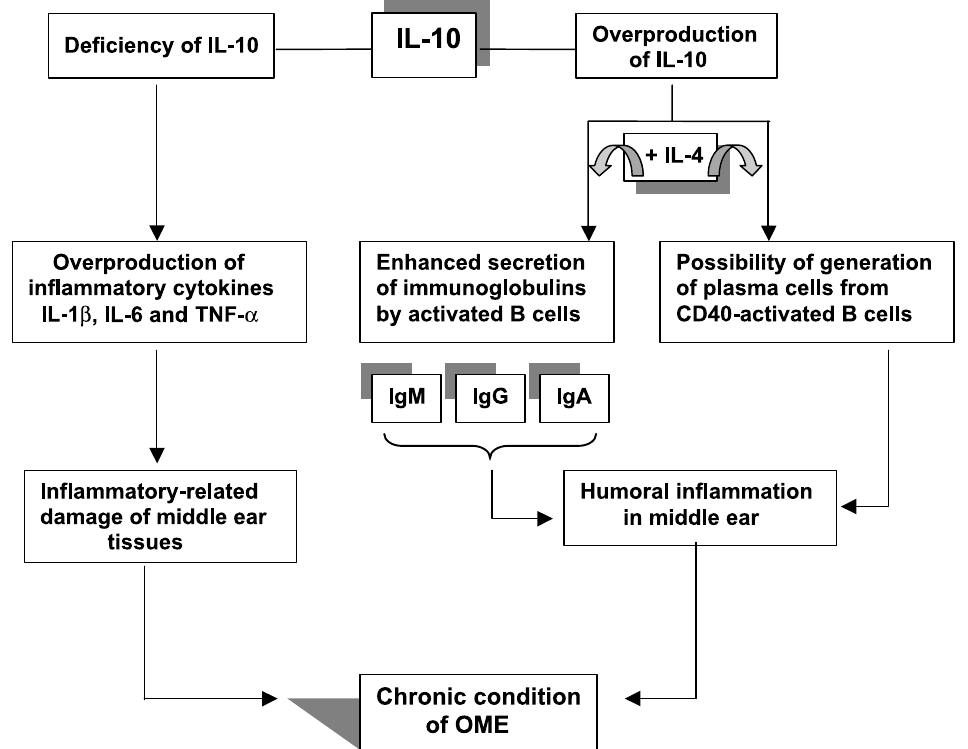
FIG. 4. Cellular and molecular consequences of the unbalanced production of IL-10 in the course of the middle ear inflammation leading to the chronic condition of